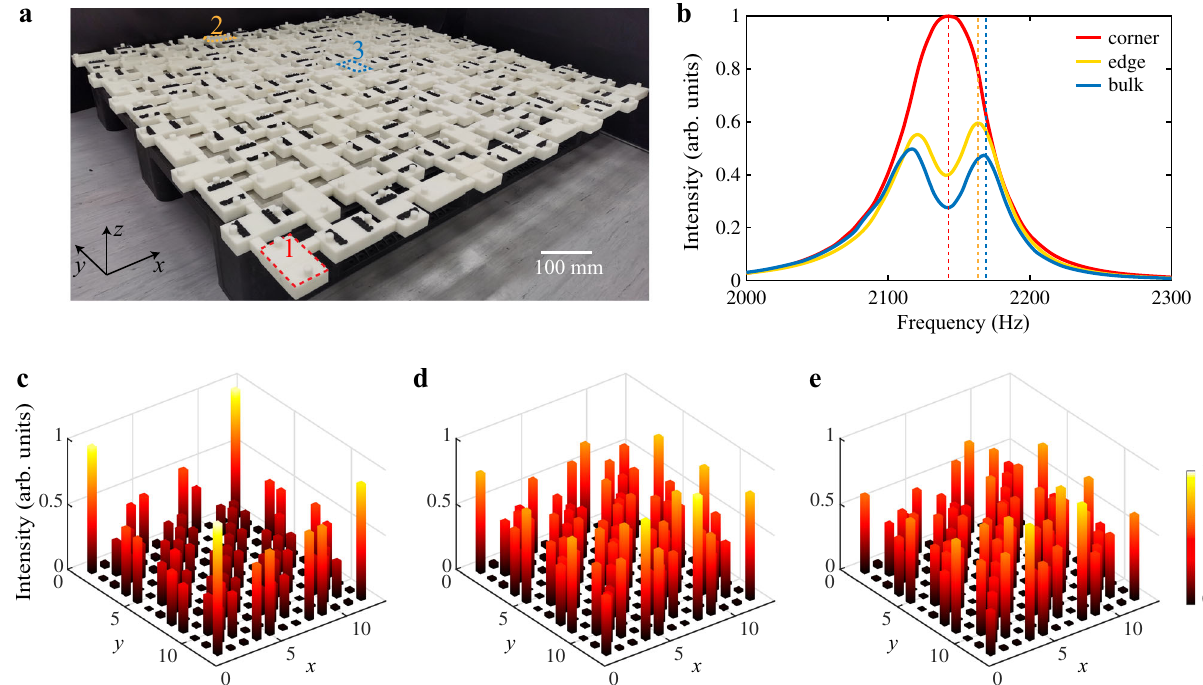
Fig. 3 Experimental observation in the nontrivial lattice. a Photo of a 3D printed lattice with 12 × 12 resonators. b Measured acoustic intensity spectra for the sample in ( a ). Red, yellow, and blue curves represent the corner, edge, bulk spectra measured at the resonators labeled as “ 1 ” , “ 2 ” , and “ 3 ” in ( a ), respectively. c – e Measured intensity pro fi les at the peaks of the corner, edge, bulk spectra, denoted by the red (2142Hz), yellow (2164 Hz), and blue (2170 Hz) dashed lines in ( b ), respectively. In c – e , both the height and color of each bar indicate the power